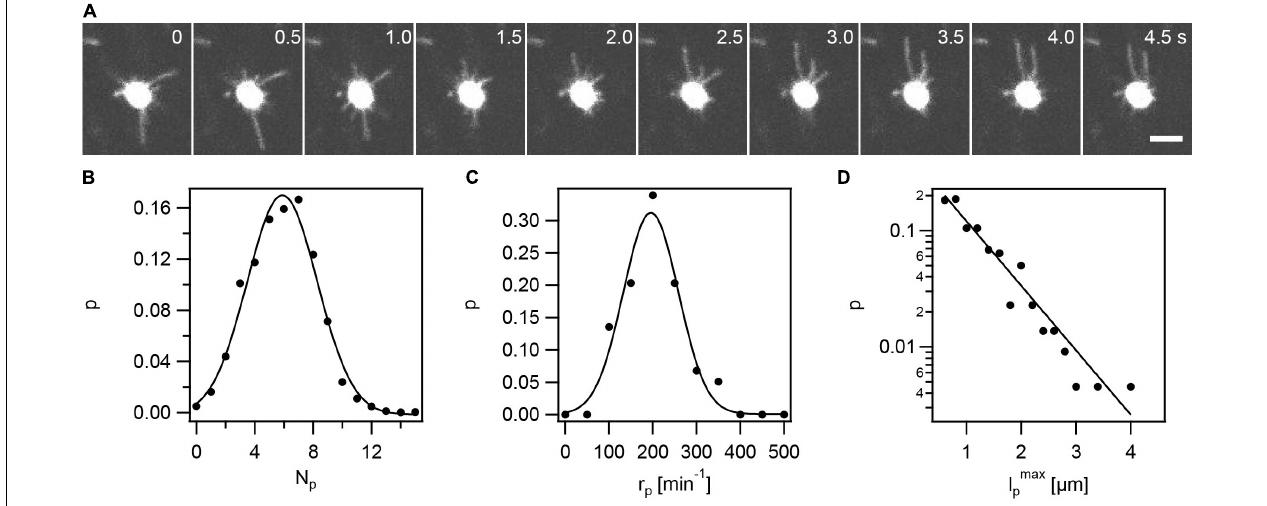
FIGURE 1 | Visualization of fluorescent T4P in N. gonorrhoeae (Ng226). (A) Time lapse of gonococcus with AF488-labeled T4P. Scale bar: 2 µ m. (B) Circles: Probability (p) distribution of number of T4P per cell, N p . Full line: Gaussian fit with (cid:10) N p (cid:11) = 5 . 9 ± 0 . 1 (mean from 59 cells ± standard error). (C) Circles: Probability distribution of rates of T4P production per cell, r p . Full line: Gaussian fit with (cid:10) r p (cid:11) = ( 196 ± 3 ) min − 1 (mean of 59 cells ± standard error). (D) Circles: Probability distribution of T4P lengths l pmax (derived from 220 T4P). l pmax specifies the maximum length of a T4P, i.e., the length at the point in time where the T4P switches from elongation to retraction. Full line: exponential fit with characteristic length l c p = ( 0 . 78 ± 0 . 06 ) µ m